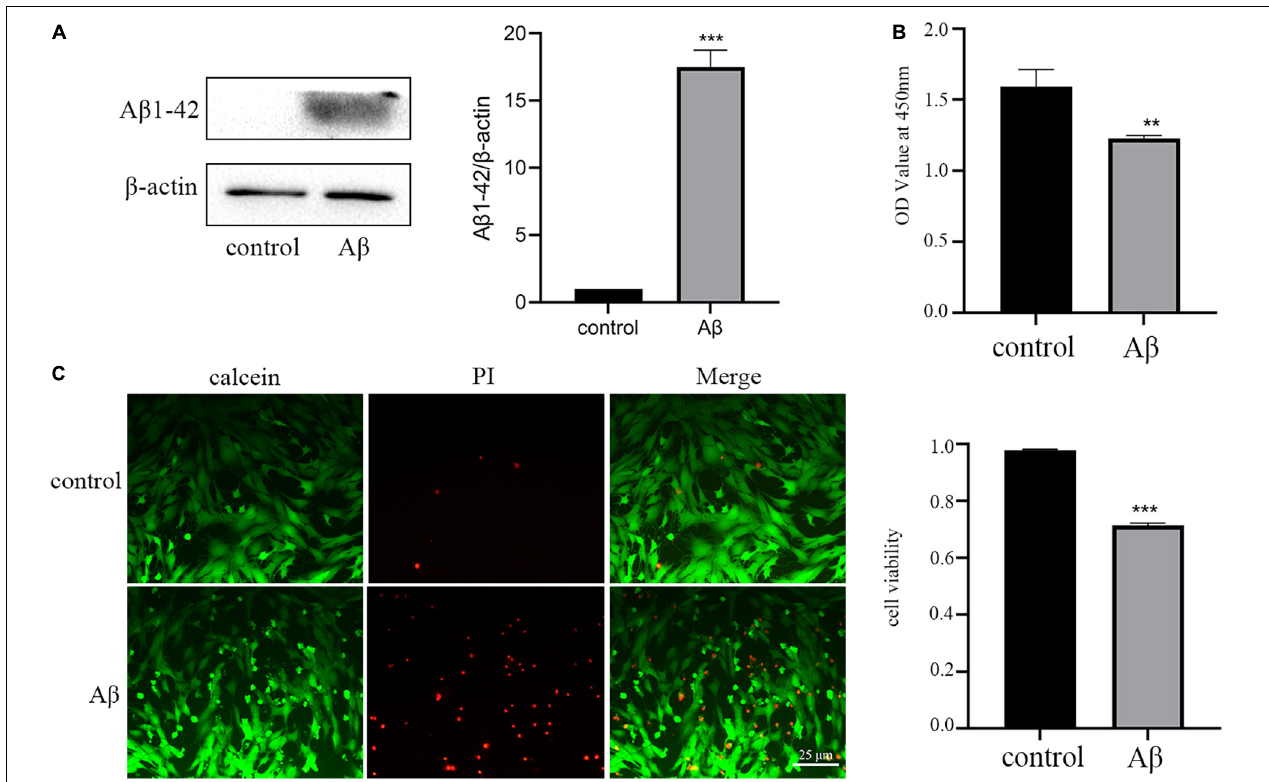
FIGURE 1 | Amyloid- β protein fragment 1–42 (A β ) treatment upregulation of A β 1-42 and reduces neuronal viability. (A) The expression of AD marker A β 1-42 detected by Western blot analysis (B) Cell viability is determined by the CCK-8 assay. (C) Cell viability is measured by calcein/PI staining. All experiments were repeated three times. ** P < 0.01 vs. control, *** P < 0.001 vs.